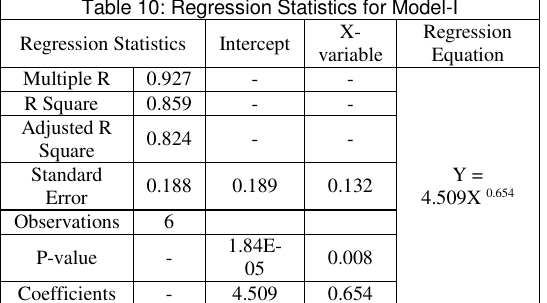
Table 10: Regression Statistics for Model-I